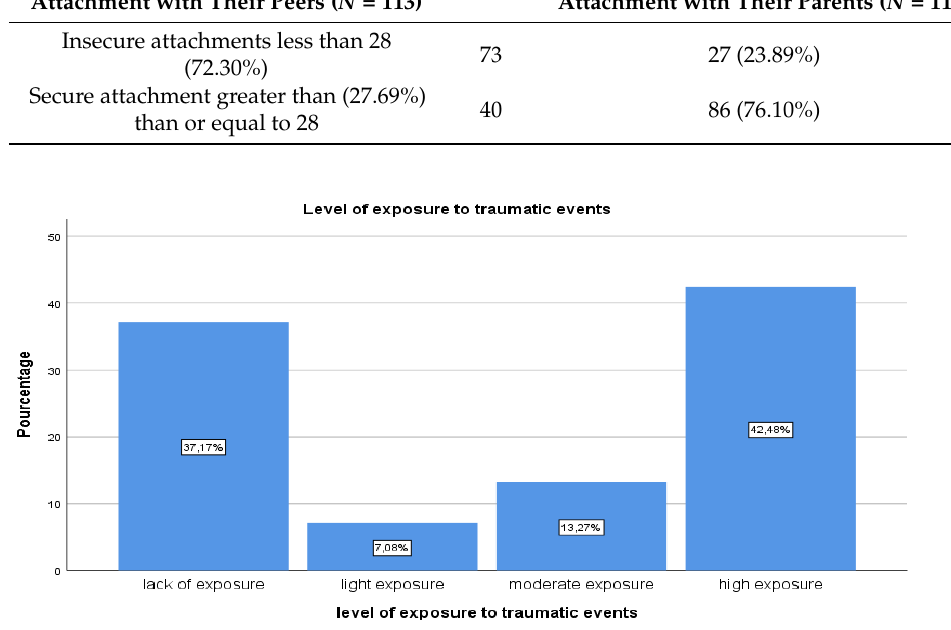
Figure 2. Level of exposure to traumatic events